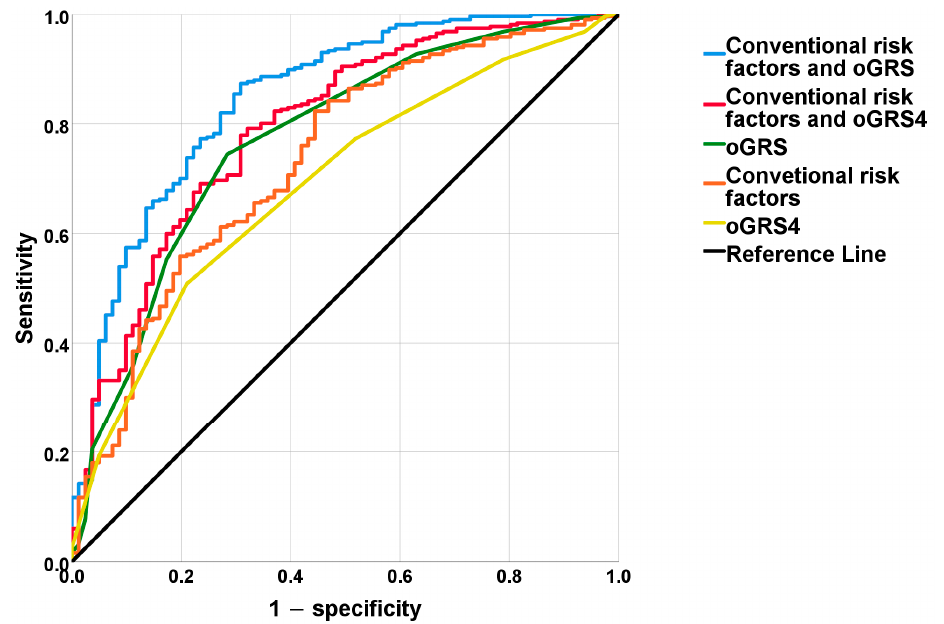
Figure 3. Results of receiver operating characteristic curve analysis for conventional risk factors (age, sex, education, and BMI—orange line) and genetic risk (based on the optimized genetic risk score (oGRS)—green line and oGRS 4 —yellow line) and the combination of conventional risk factors with oGRS (blue line) and the combination of conventional risk factors with oGRS 4 (red line). The y -axis indicates sensitivity, and the x -axis indicates 1 − specificity. The black line represents a random predictive value of the model which is considered as a reference (area under the receiver operating characteristic (ROC) curve − AUC ref. = 0.500).